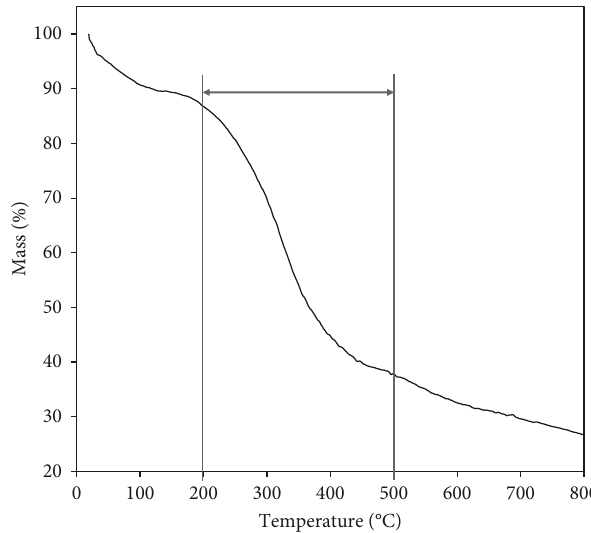
Figure 2: The TG analysis of rice straw lignin.